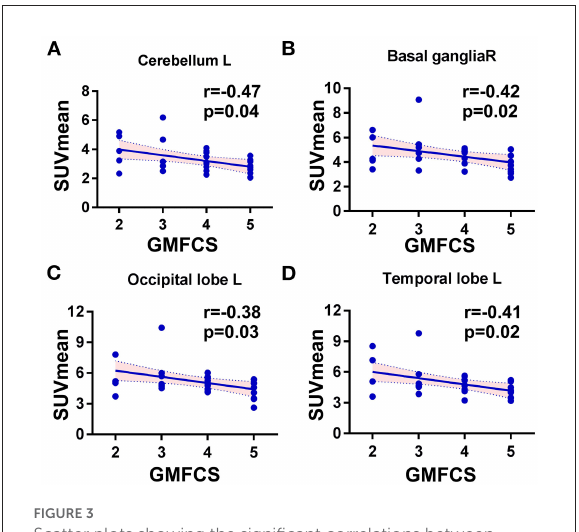
FIGURE3 Scatter plots showing the significant correlations between GMFC levels and regional SUVmean in CP patients. (A) The cerebellum, left side: Spearman r = − 0.47, p = 0.01. (B) The basal ganglia, right: Spearman r = − 0.42, p = 0.02. (C) The occipital lobe, left side: Spearman r = − 0.39, p = 0.02. (D) The temporal lobe, left side: Spearman r = − 0.41, p =